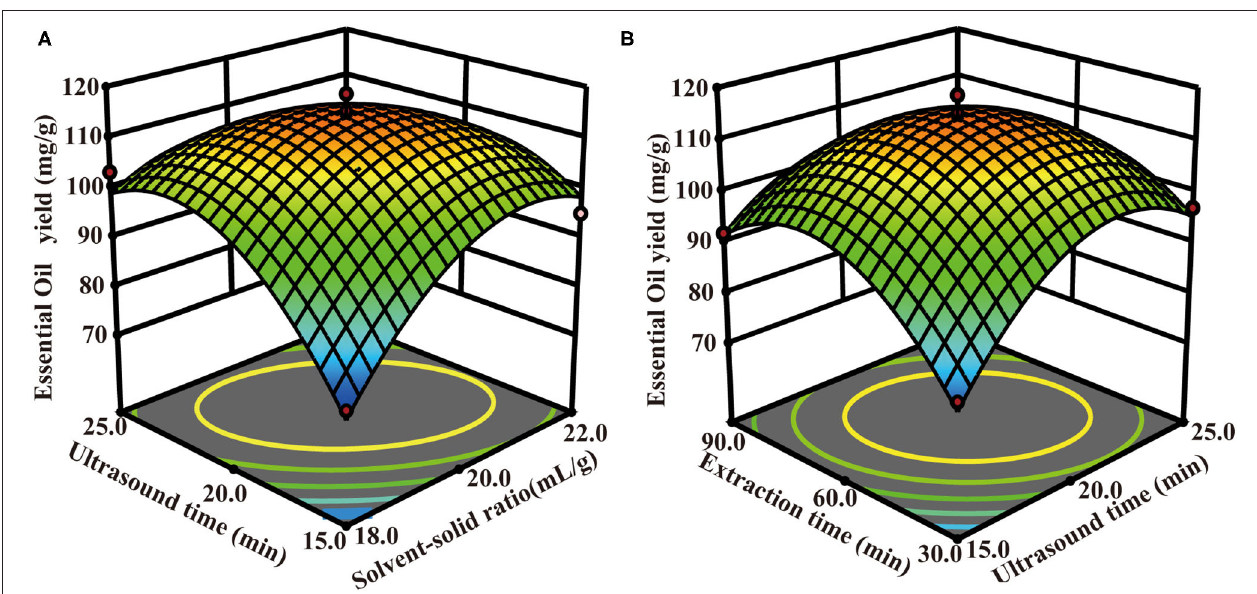
FIGURE 5 | The optimization of the UAPE extraction process. (A) The interaction of solvent-solid ratio and ultrasound time; (B) the interaction of ultrasound time and extraction